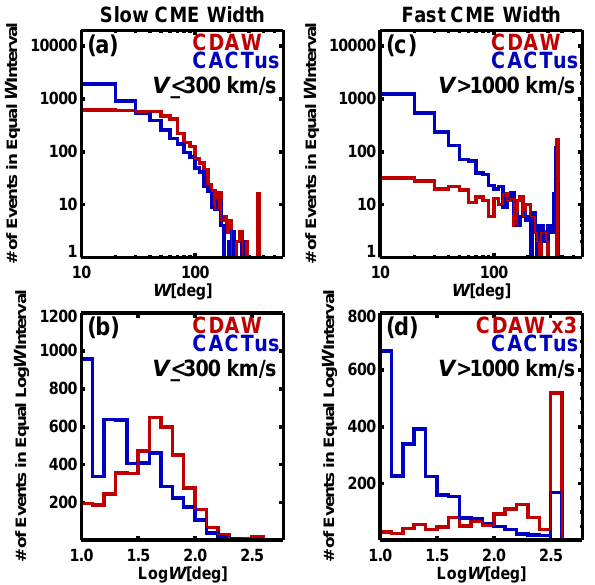
Fig. 4. Angular width distributions of slow ( V < 300km/s; left) and fast ( V > 1000km/s; right) CMEs. Red and Blue lines are for CDAW and CACTus events, respectively. In panel d, the numbers of CDAW events are multiplied by 3 for